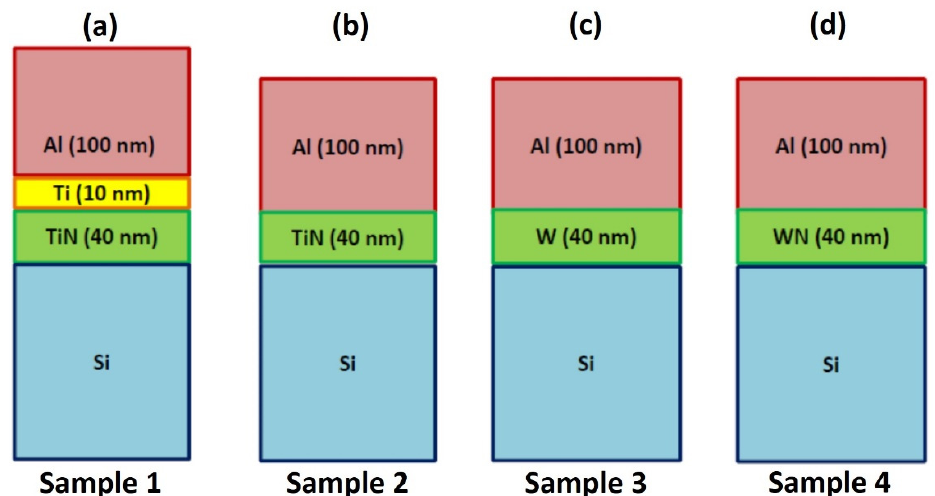
Figure 1. Picture reporting the scheme of the four samples analyzed in this work. ( a ), Sample 1: Al(100 nm)/Ti(10 nm)/TiN(40 nm)/Si, ( b ), sample 2: Al(100 nm)/TiN(40 nm)/Si, ( c ), sample 3: Al(100 nm)/W(40 nm)/Si, ( d ), sample 4: Al(100 nm)/WN(40 nm)/Si. In each sample, the Si is the substrate, the surface Al layer is the electrical contact and the layers between Al and Si are the materials used as diffusion barriers.